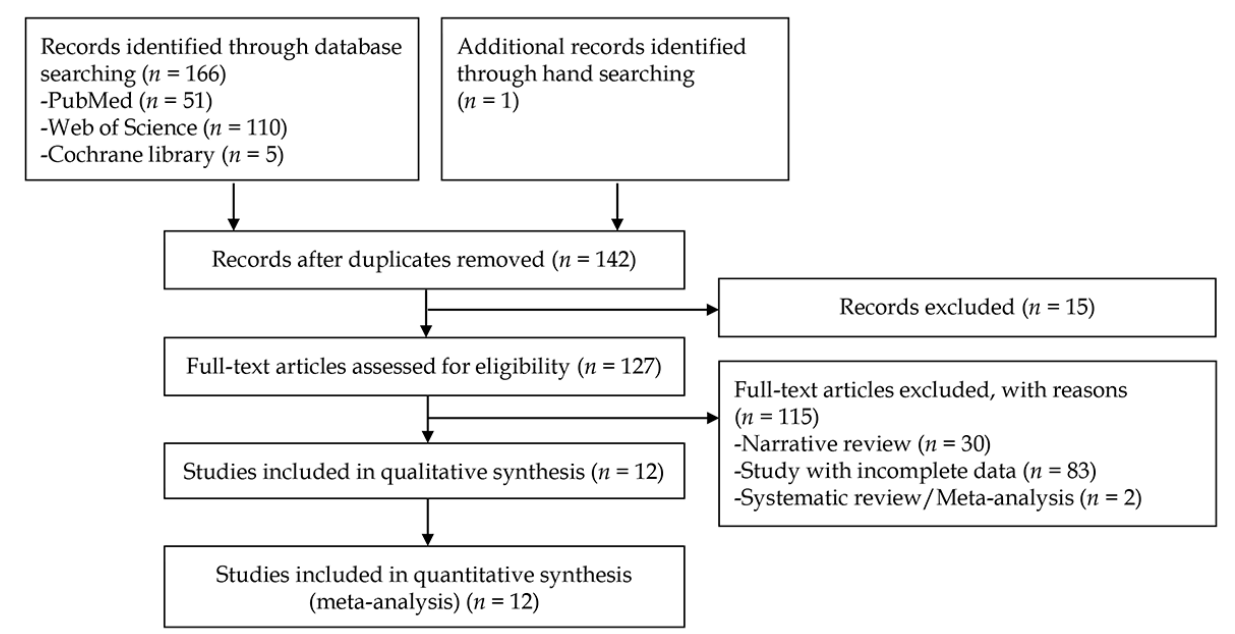
Figure 1. Flow chart of the study selection process for the diagnostic performance of computer-aided diagnosis for gastrointestinal protruded lesions using wireless capsule endoscopy.